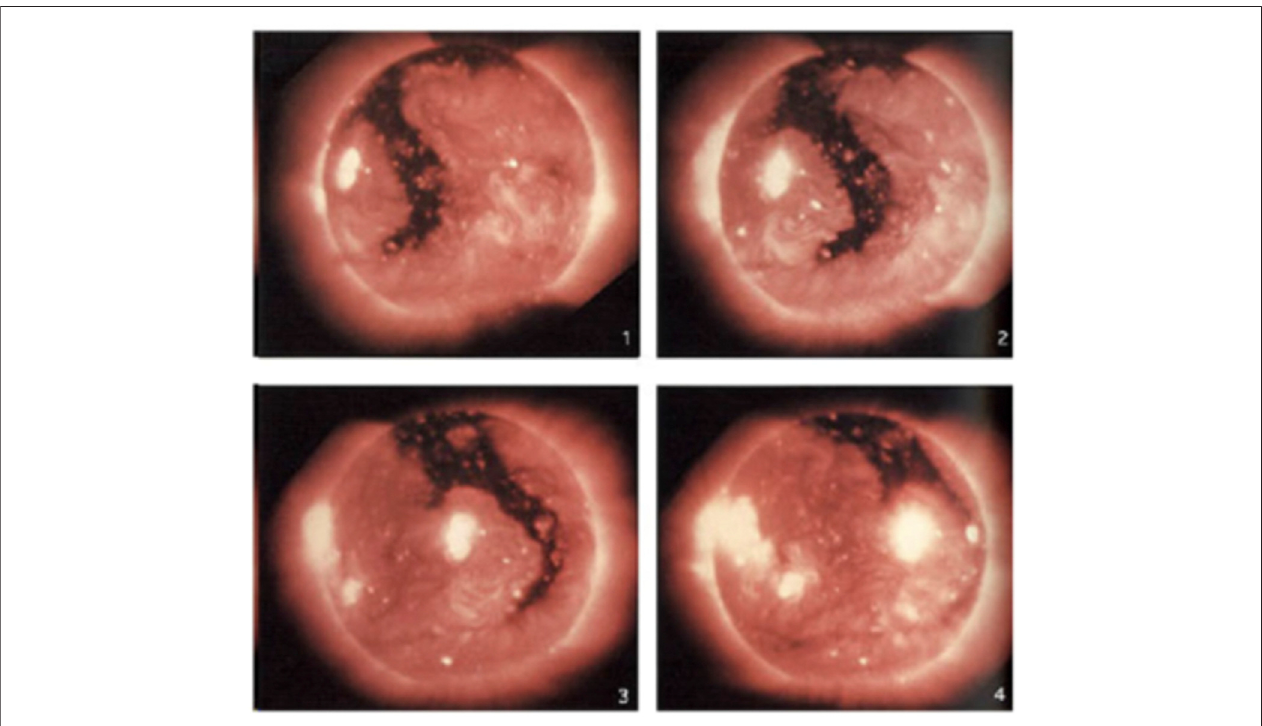
FIGURE7| FourimagesofsoftX-rayobservationsofacoronalhole(darkregion)extendingfromthenorthpoletotheequatoroftheSun.Theseimagesweretaken 2 days apart (Richardson, 2018). These images were distributed under the https://creativecommons.org/licenses/by/2.0/legalcode Creative Commons Attribution 2.0 International